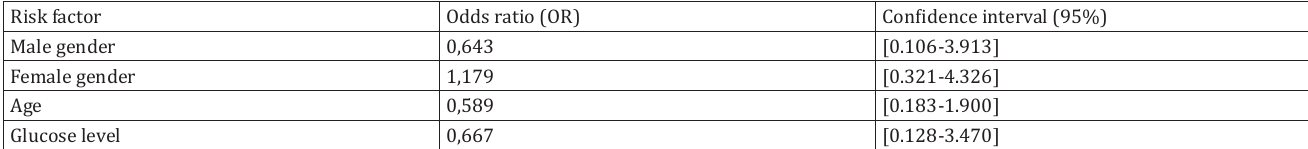
Assessment of the impact of clinical data in patients with chronic pancreatitis on the risk of diabetes